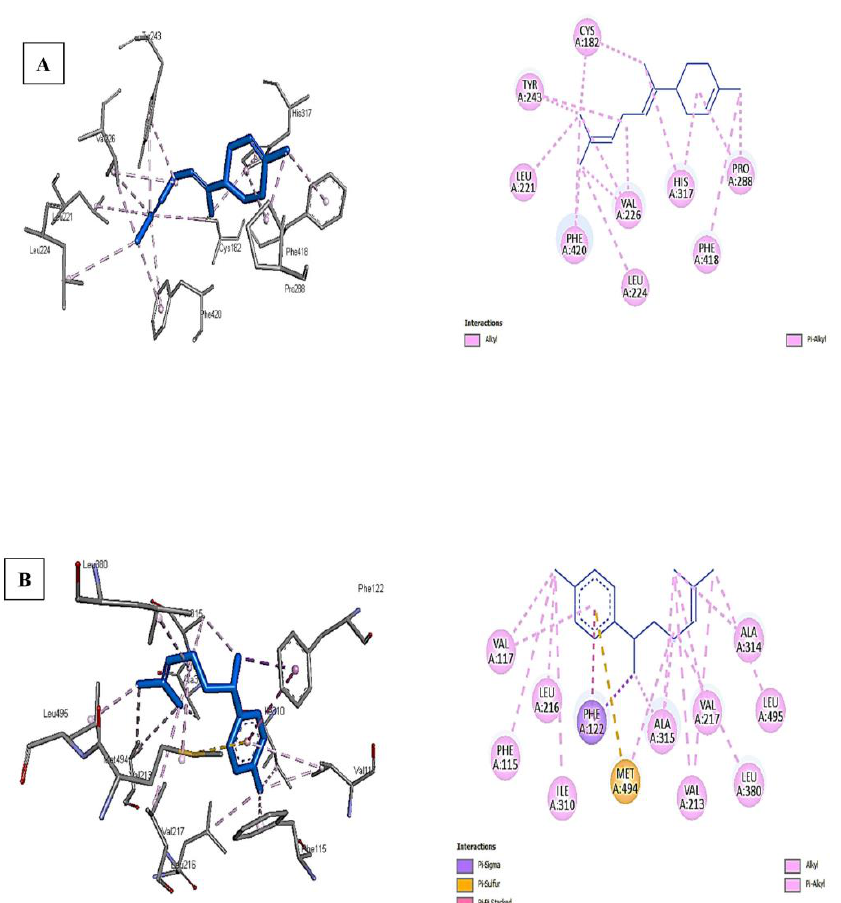
Figure 3. The interactions of α -bisabolene with polyketide synthase ( A ) and ar -curcumene with cytochrome P450 monooxygenase ( B ).